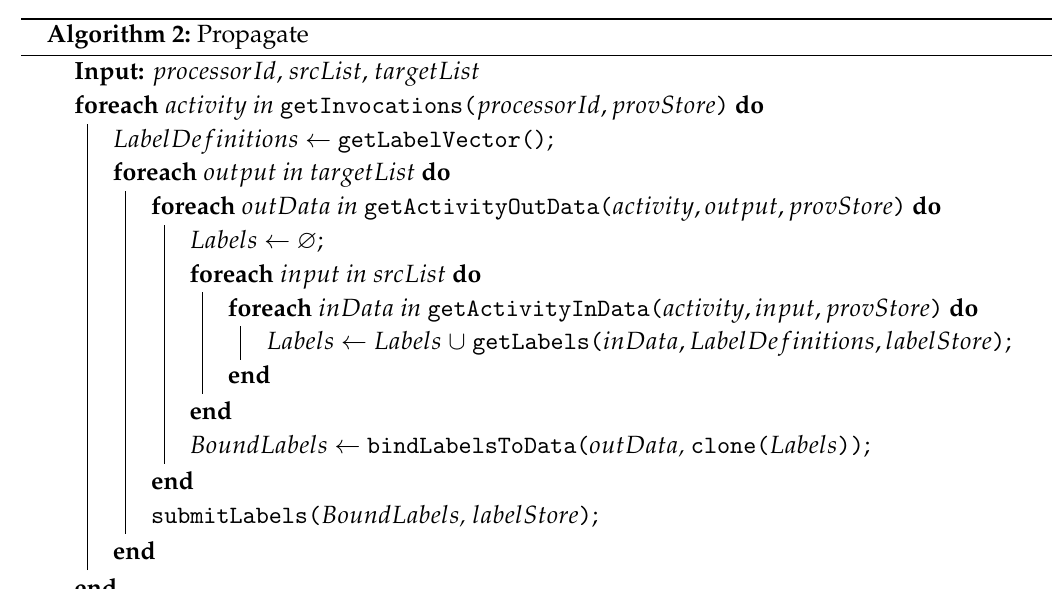
Figure 10. Propagate Operator